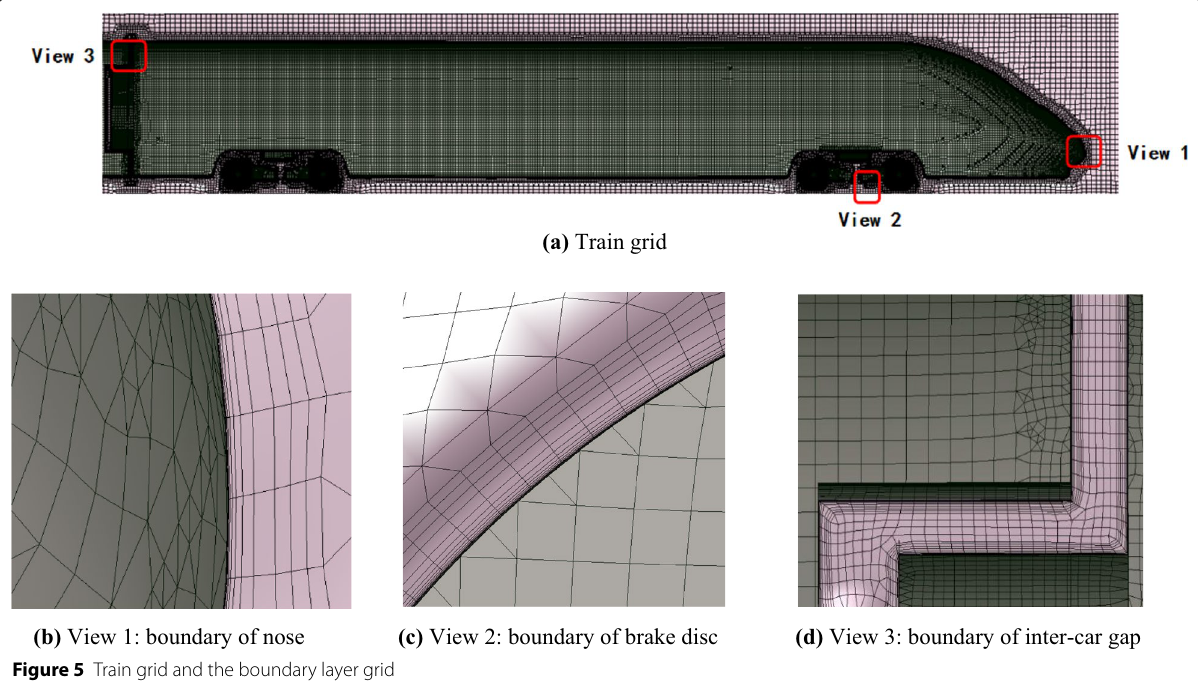
Figure 5 Train grid and the boundary layer grid